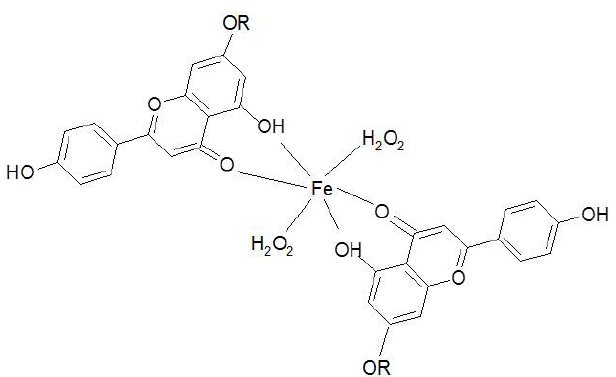
FIGURE 6 - Molecular structure of naringin and